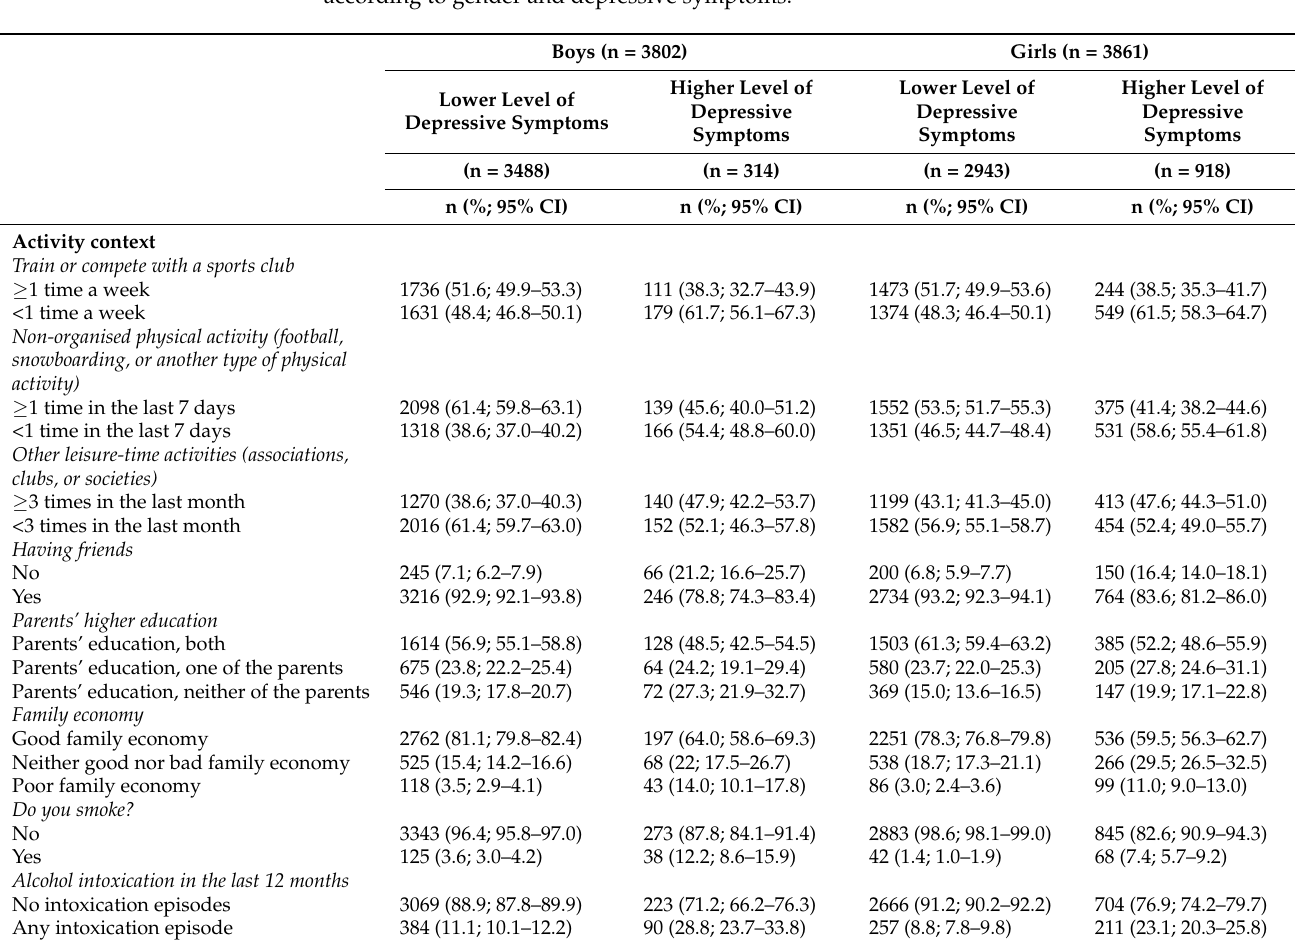
Table 2. Youth data surveys: baseline characteristics of adolescents aged 13–16 years in 2017–2019 according to gender and depressive